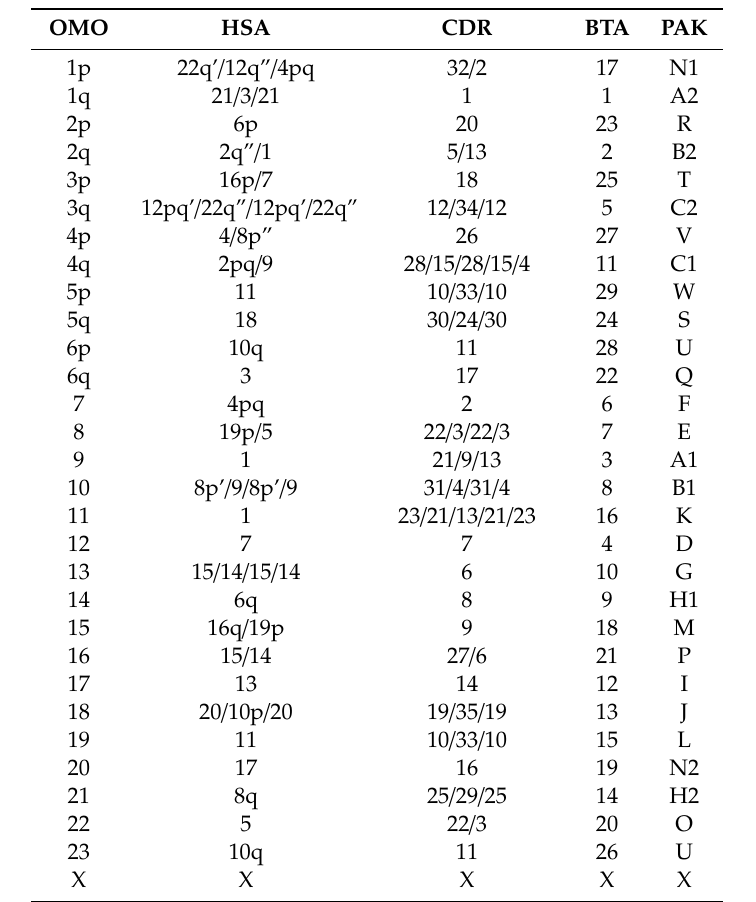
Table 2. Correspondence between conserved chromosomal segments in musk ox (OMO), human (HSA), dromedary (CDR), cattle (BTA) and Pecoran ancestral karyotype (PAK) [5] revealed by chromosome painting. The order of conservative segments is started from